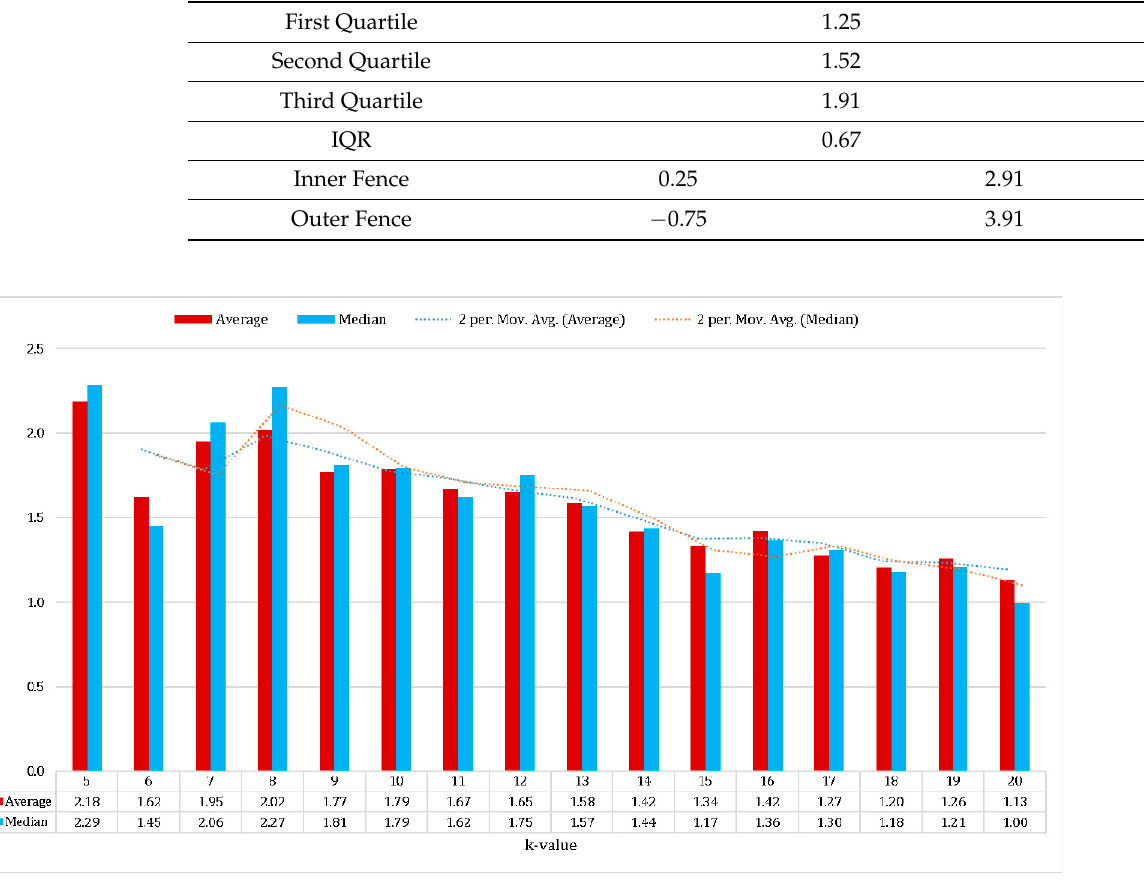
Figure 3. The average and median scores at different